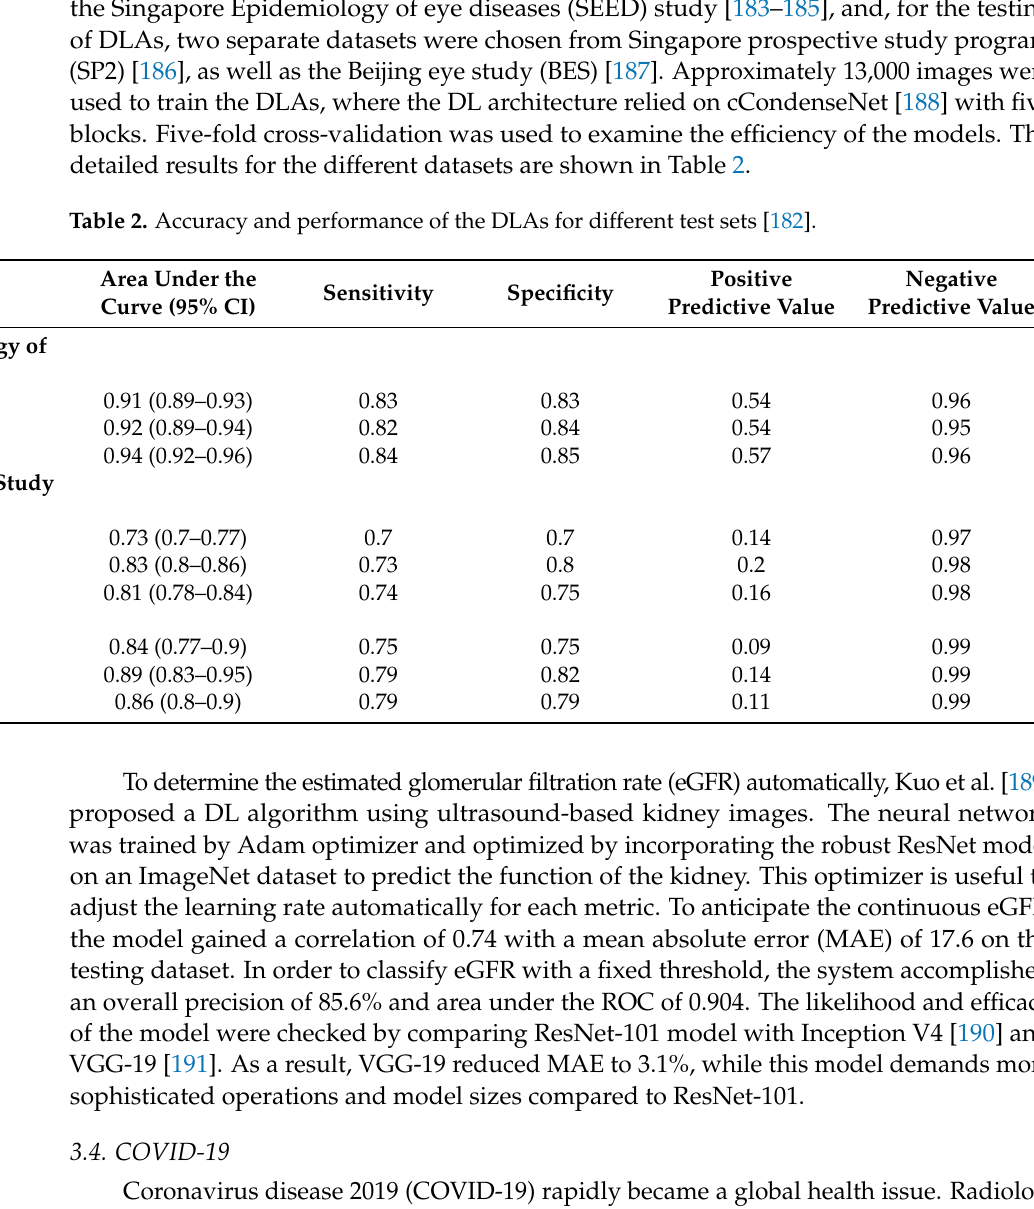
Table 2. Accuracy and performance of the DLAs for different test sets [182]. Area Under the Sensitivity Specificity Curve (95% CI)